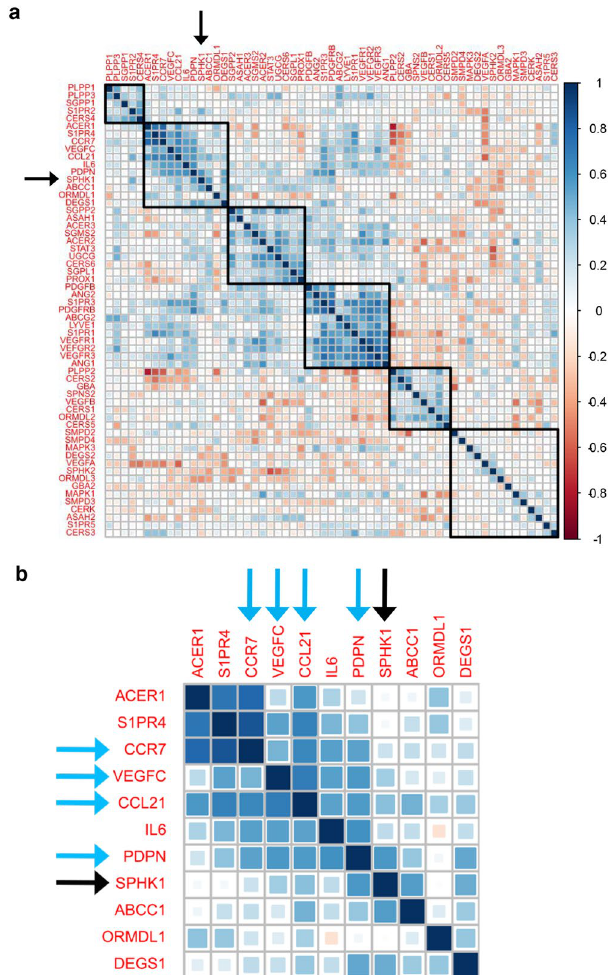
Figure 4. The gene expression level of SPHK1 is associated with those of lymphangiogenesis-related or lymphatic metastasis-related substrates in biliary tract cancer. ( a ) The correlation matrix analysis was performed for gene expression levels of substrates associated with S1P and ceramide biosynthetic pathway, angiogenesis, lymphangiogenesis or lymphatic metastasis in biliary tract cancer in TCGA cohort (36 samples of cancer tissue in cholangiocarcinoma cohort). ( b ) Substrates in the same group with SPHK1 in the correlation matrix analysis were closed up. Pearson correlations were calculated based on the expression levels of interested genes in cancer tissues. The hierarchical clustering method was used for the grouping of the genes. Blue squares indicated positive correlation and red squares indicated inverse correlation. Black arrows pointed to SPHK1 and blue arrows pointed to lymphangiogenesis-related or lymphatic metastasis-related